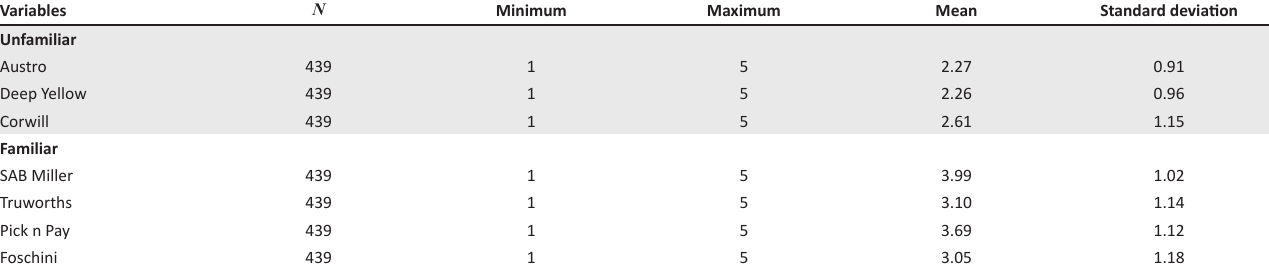
TABLE 3: Descriptive statistics: Familiar versus unfamiliar corporate brands. Variables